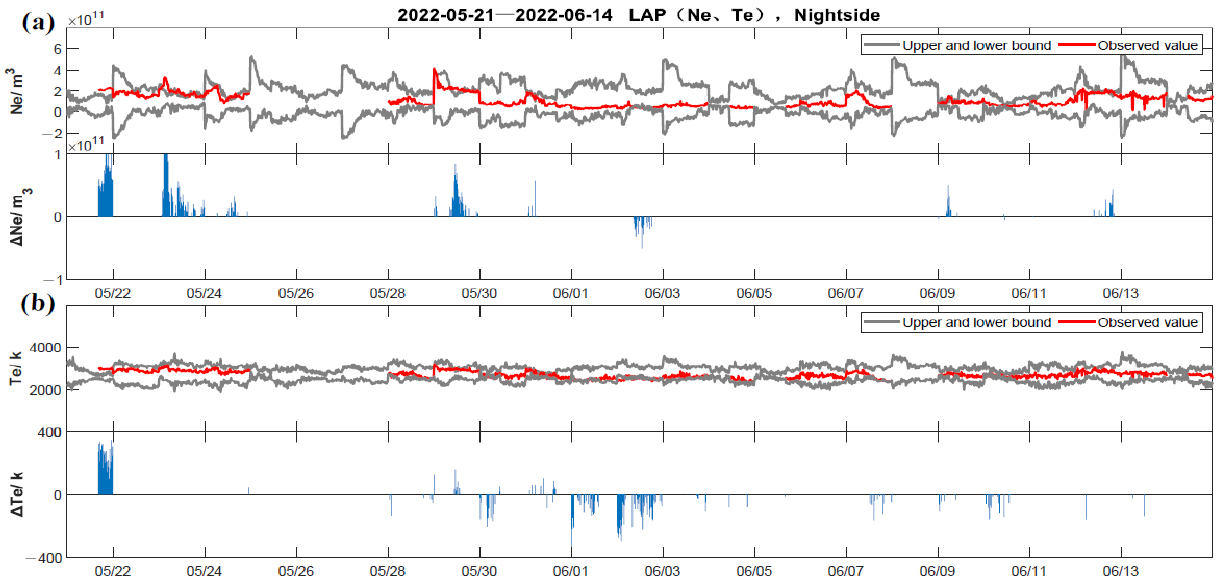
Figure 7. Temporal variations of Ne and Te. ( a ) Ne; ( b ) Te. The upper and lower bounds are shown in gray, and observed values are shown in red. The abnormal values are shown in blue, represented as ∆ Ne and ∆